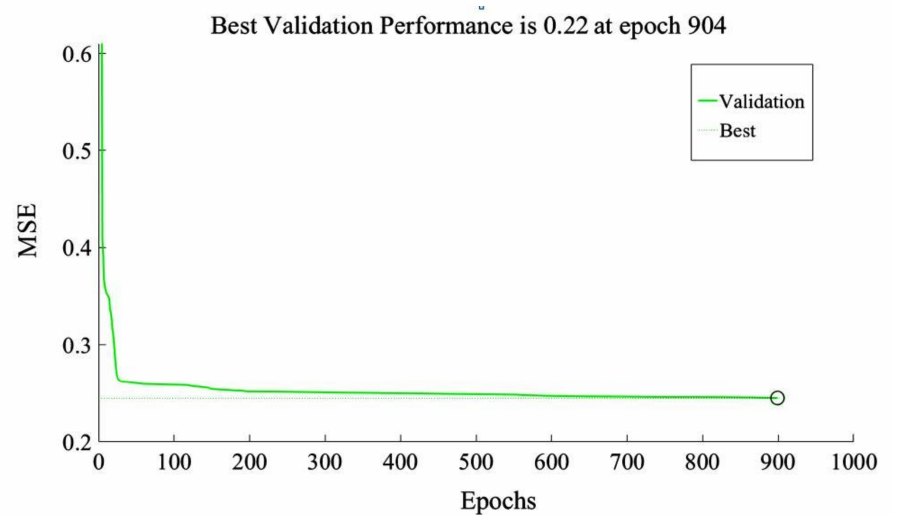
Figure 5. Validation error curves.